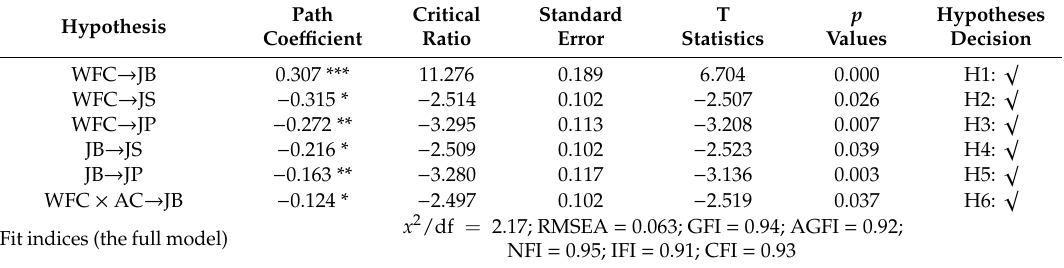
Figure 3. SEM test results. Note: *, p < 0.05. **, p < 0.01. ***, p < 0.001. Table 4. Results of theoretical model analysis.